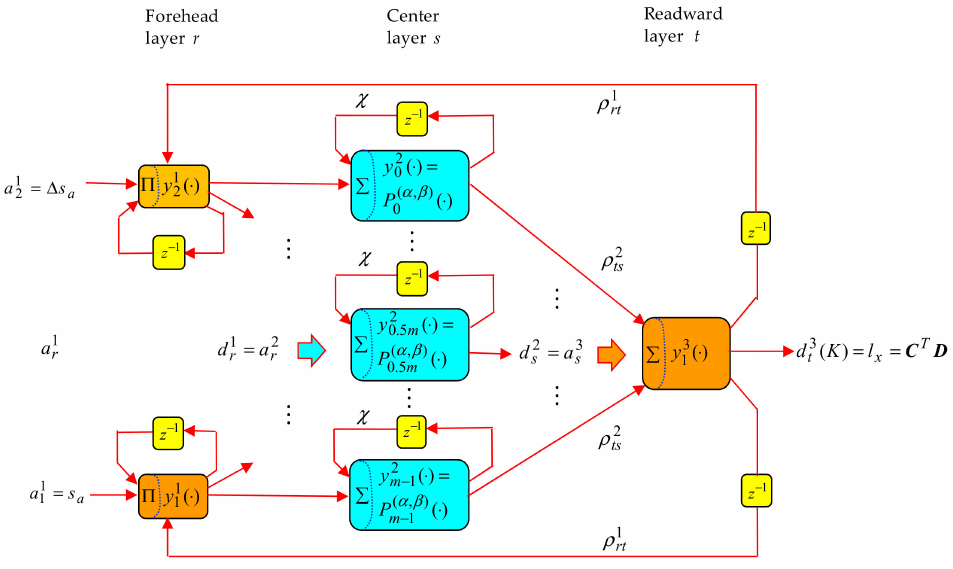
Figure 4. Constitution of the revised recurrent Jacobi polynomial neural network